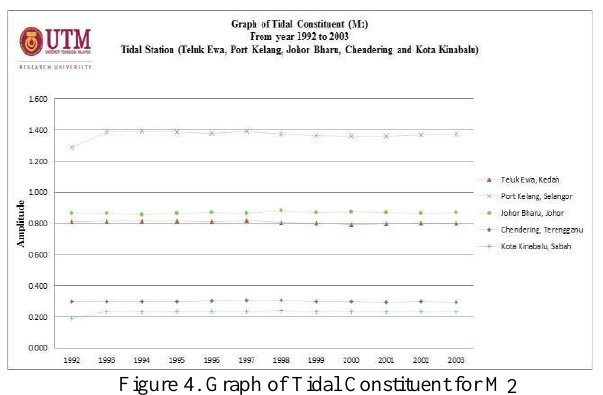
Figure 4. Graph of Tidal Constituent for M2